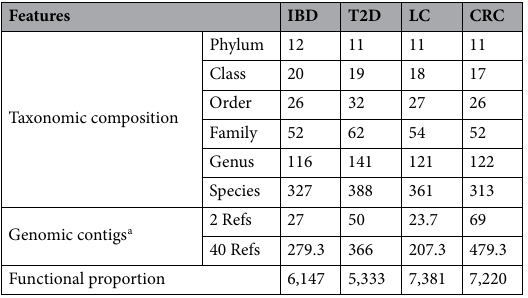
Features IBD T2D